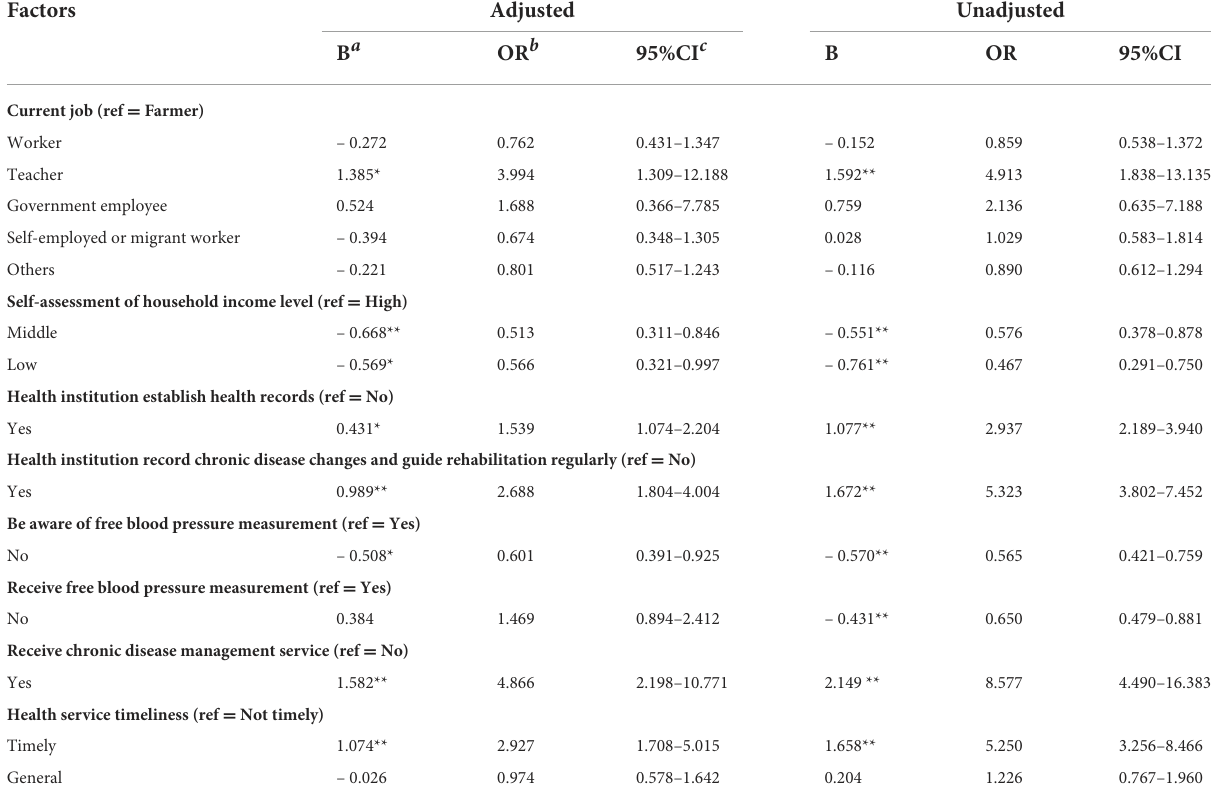
TABLE 4 Outcome of logistic regression analysis for examining associated factors of self-reported effect of chronic disease control. Factors